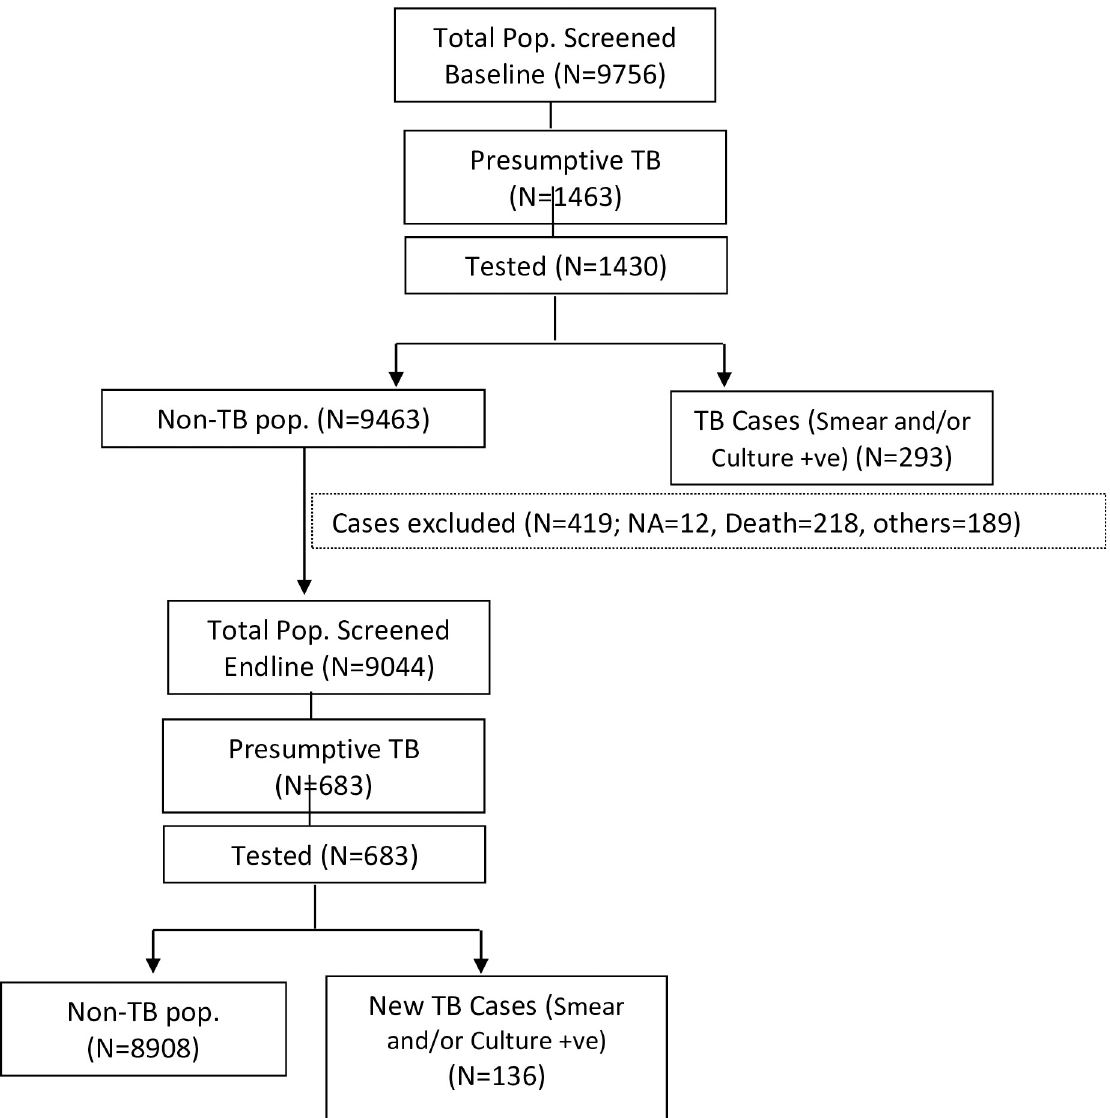
Fig 1. Flow chart of activities. Note: Detected NTB cases were excluded from TB